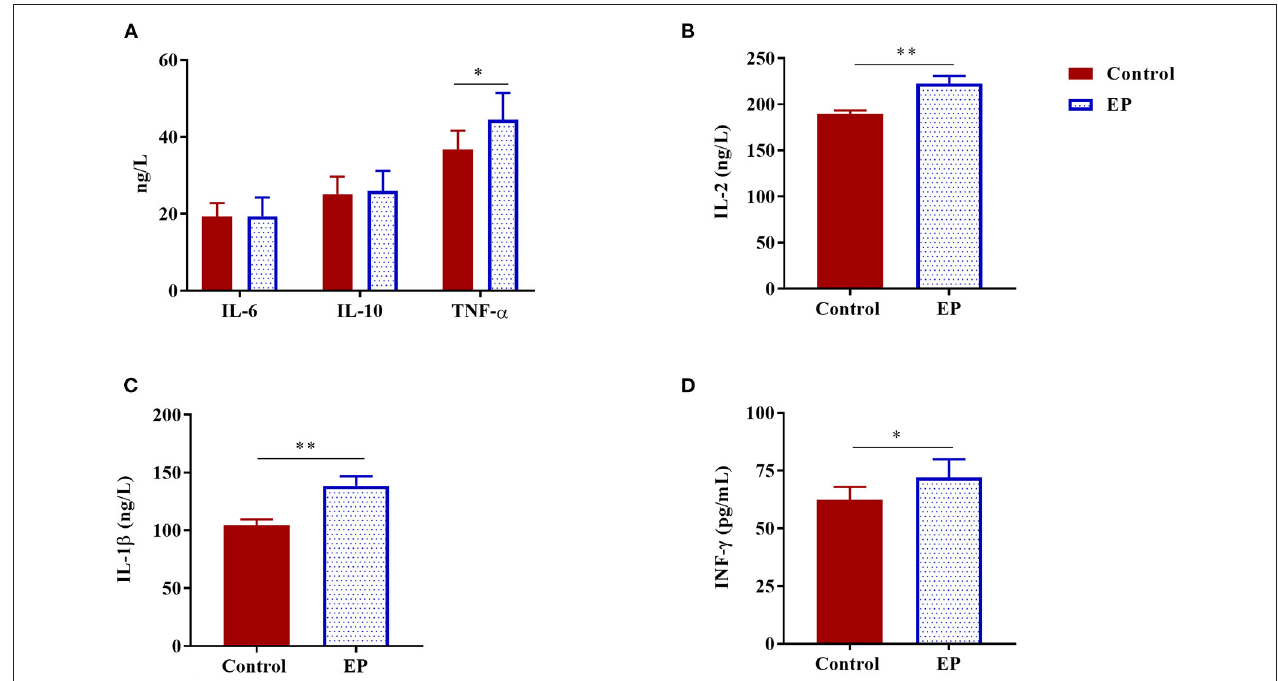
FIGURE 1 | The effects of dietary EP supplementation on serum cytokine levels of broiler chickens. Data are presented as mean ± SEM, n = 10. * P < 0.05 and ** P < 0.01, respectively. (A) IL-6, Interleukin 6; IL-10, Interleukin 10; TNF- α , Tumor necrosis factor-alpha; (B) IL-2, Interleukin 2; (C) IL-1 β , Interleukin 1 beta; (D) IFN- γ , Interferon-gamma.